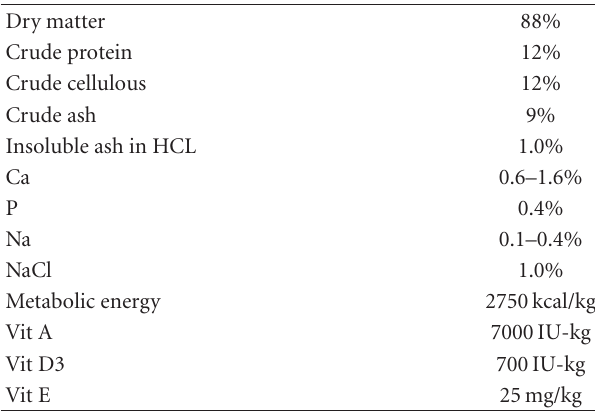
Table 1: Composition of the commercial